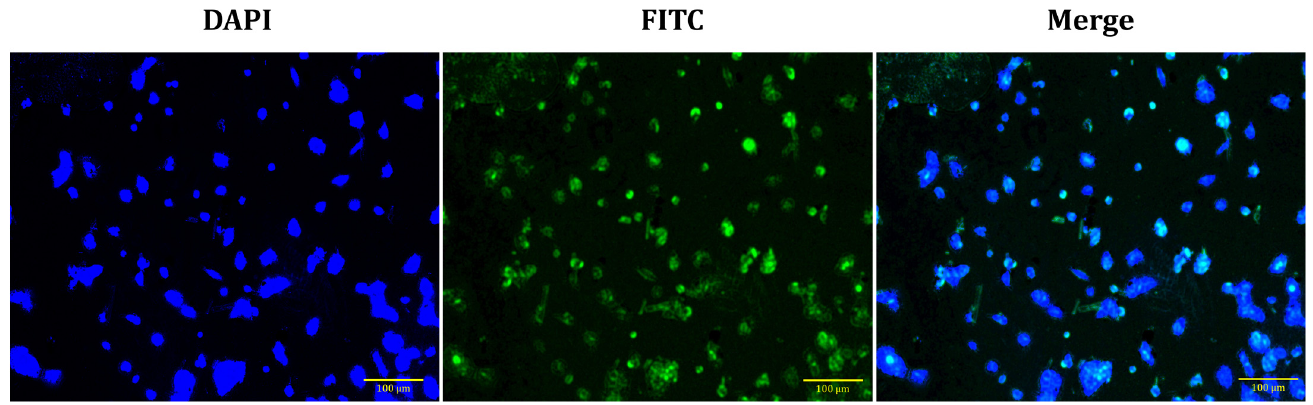
Figure 8. Cellular uptake analysis of FITC labelled Cu-BTC@PDA NWs in HepG-2 cells.